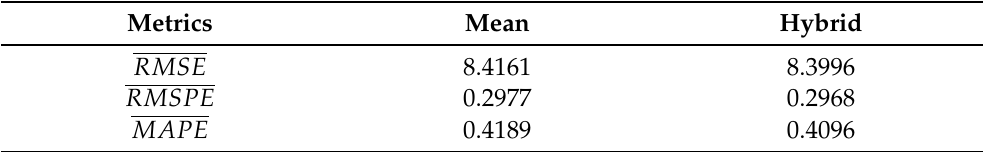
Table 2. Mean Estimator and Hybrid models performance